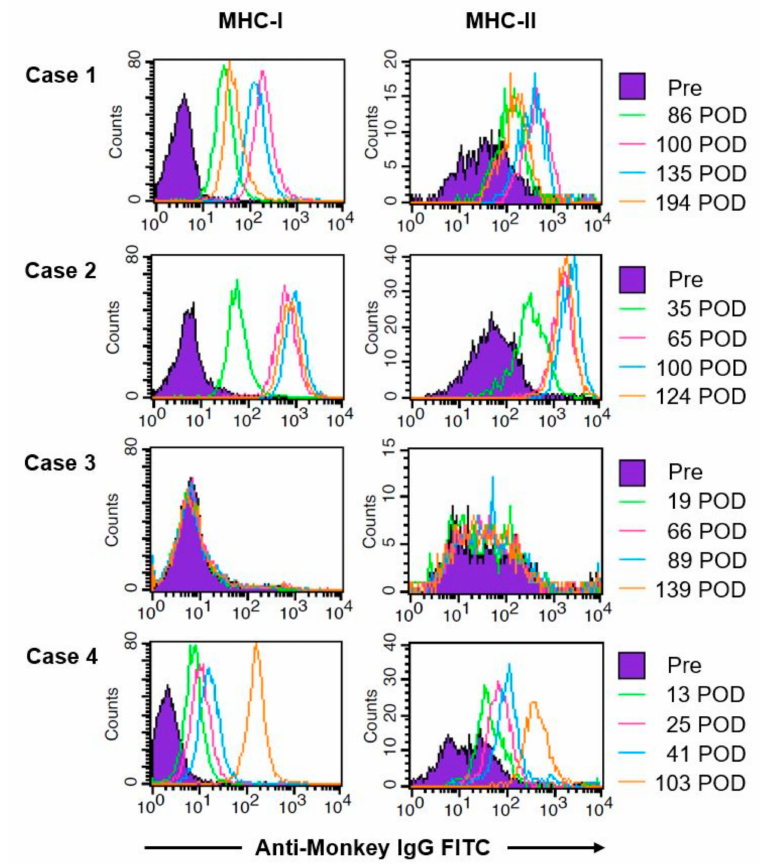
Figure 9. Changes of donor-specific antibodies (DSAs). Pre- and post-transplantation DSAs were produced against MHC class I and II in all animals except for case 3. The titers of DSAs increased